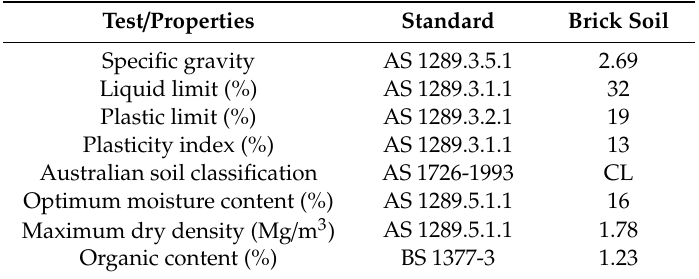
Table 1. Geotechnical Properties of the Brick Soil.